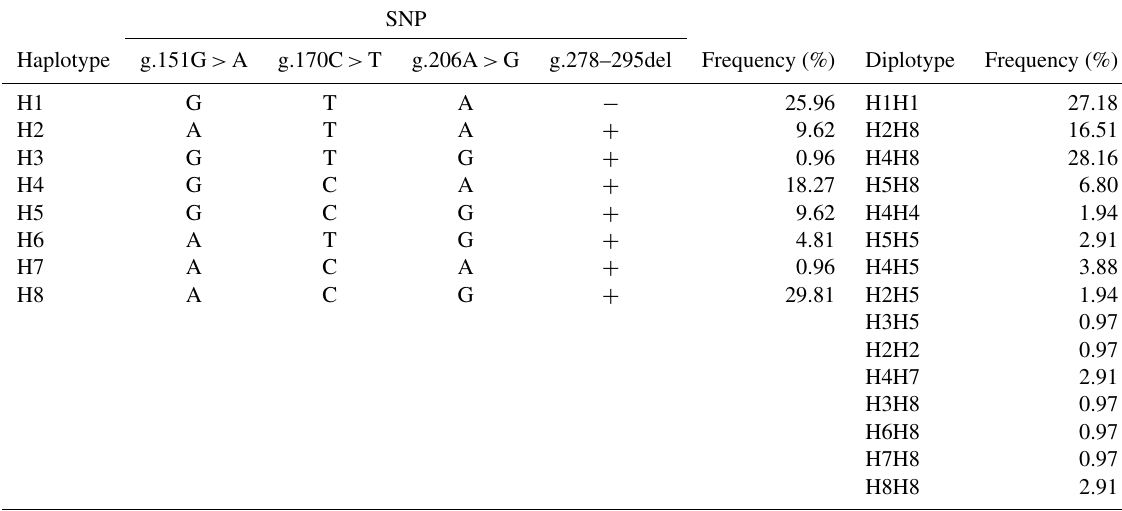
Table 2. Haplotype and diplotype frequencies in the duck VLDLR